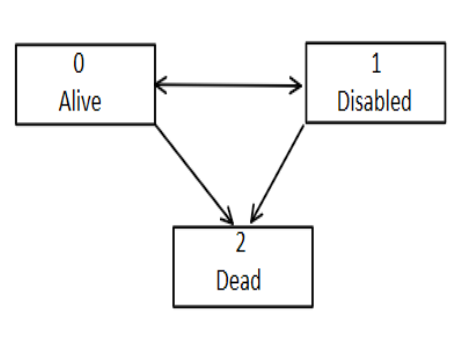
Figure 1. Temporary disability income insurance